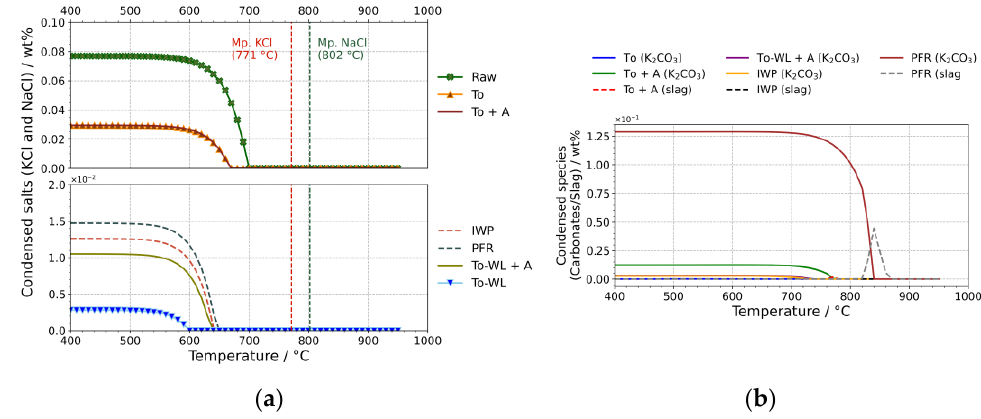
Figure 12. Condensation of salts (mostly potassium chloride) ( a ) and carbonates, as well as slag- mixtures, mainly consisting of carbonates/sulfides ( b ), calculated under gasification-like conditions. The red and green dashed lines denote the corresponding melting temperatures of KCl and NaCl. The cooling temperature is 950 °C.